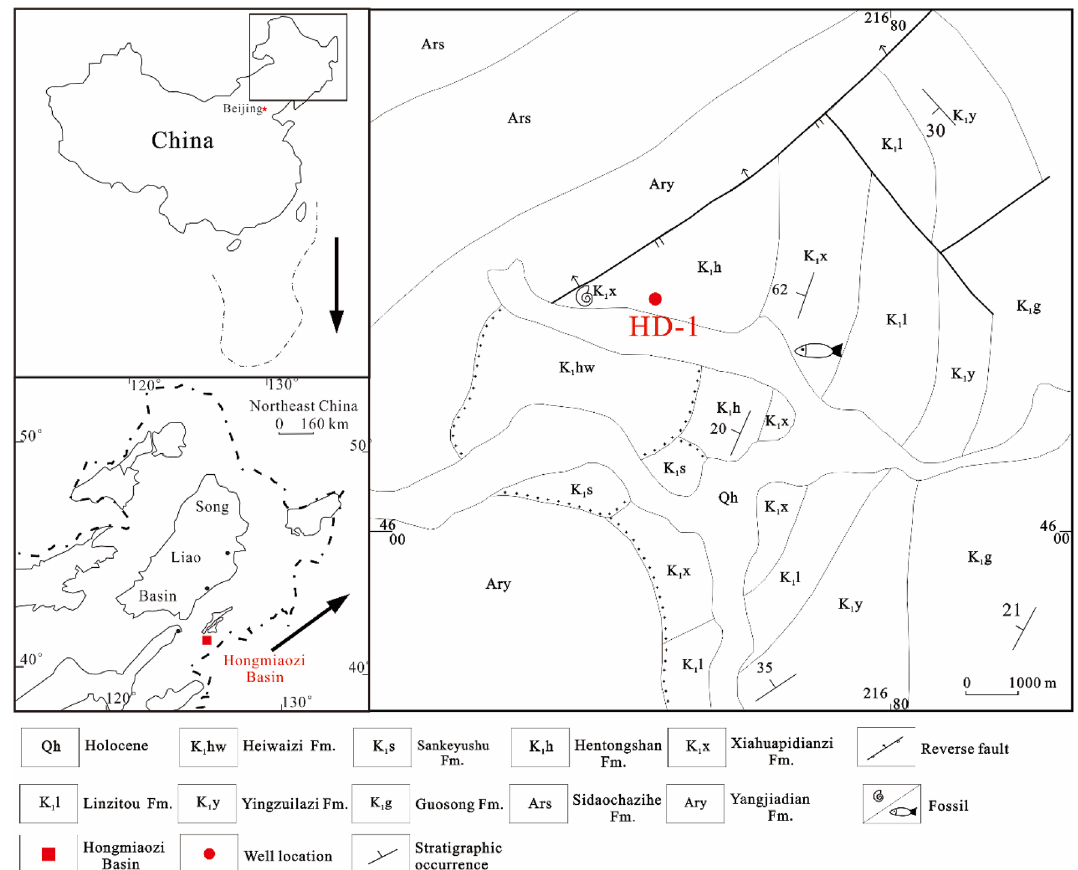
Figure 1. Location of the Hongmiaozi Basin, drilling position and stratum distribution. (This figure was drawn by CorelDRAW Graphics Suite 2019, vision number: 21.3.0.755, url: https:// www. corel. com/